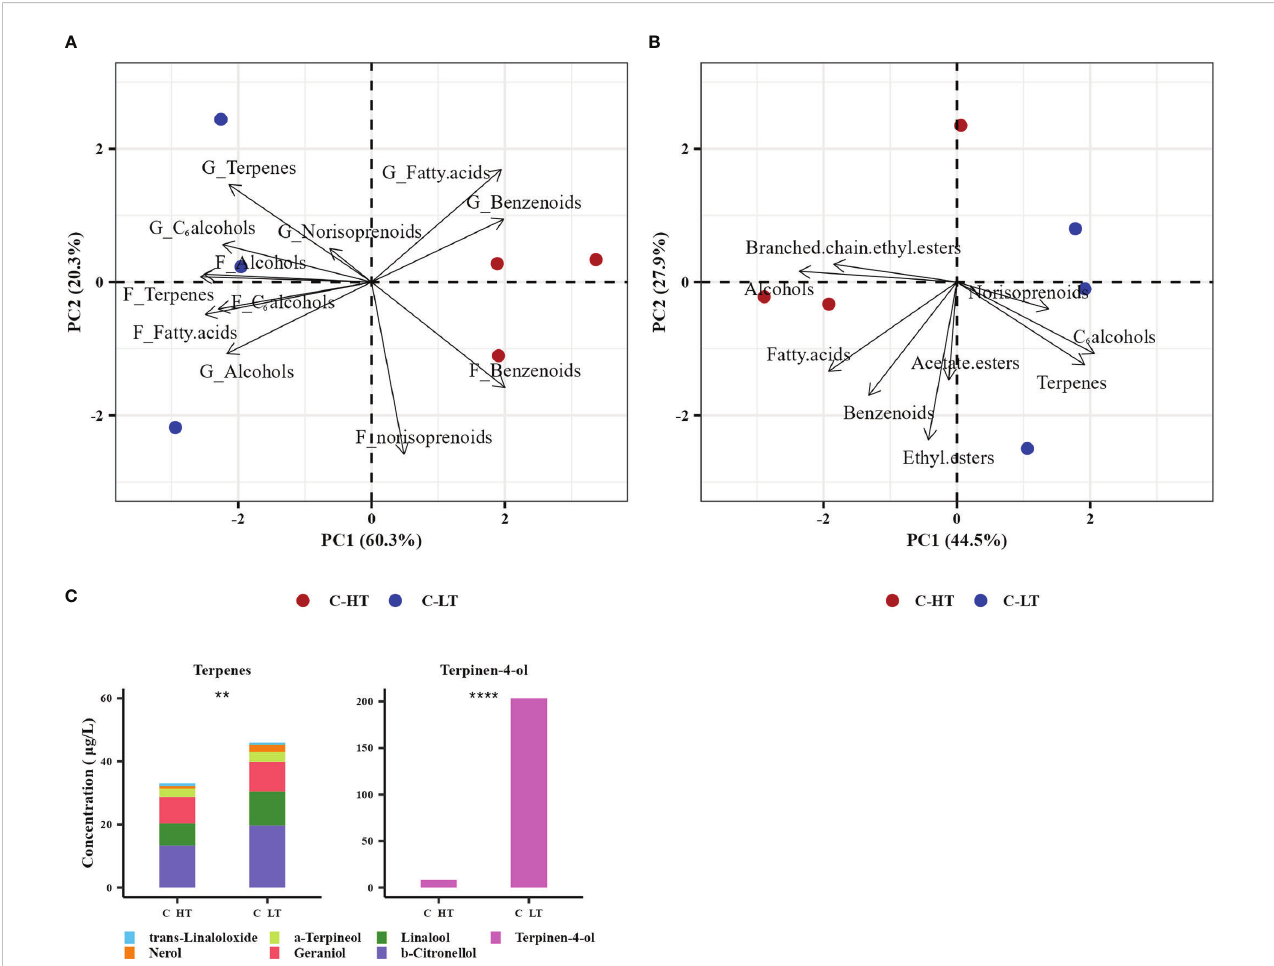
FIGURE 6 Aromatic pro fi le of grapes dehydrated in the C-HT and C-LT rooms and in the derived wines. (A) PCA biplot of grape samples withered in the different rooms (circles) and the free VOCs (pre fi x F) and glycosidic precursors (pre fi x G) families identi fi ed in them (arrows). (B) PCA biplot of the derived wine samples (circles) and the free VOCs families identi fi ed in them (arrows). (C) Bar plot of the 7 free terpenes concentration in wines derived from grape berries dehydrated in the C-HT and C-LT rooms. Speci fi c terpene accumulation is represented in different colors. Terpinen-4-ol was graphically separated due to its eminently higher concentration in both wines. Asterisks represent statistically signi fi cant difference based on t-test (p ≤ 0.01 = **; p ≤ 0.0001 = ****). Red color indicates the C-HT condition; blue color indicates the C-LT